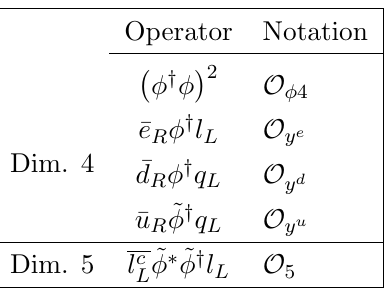
Table 4 . Operators of dimension four and